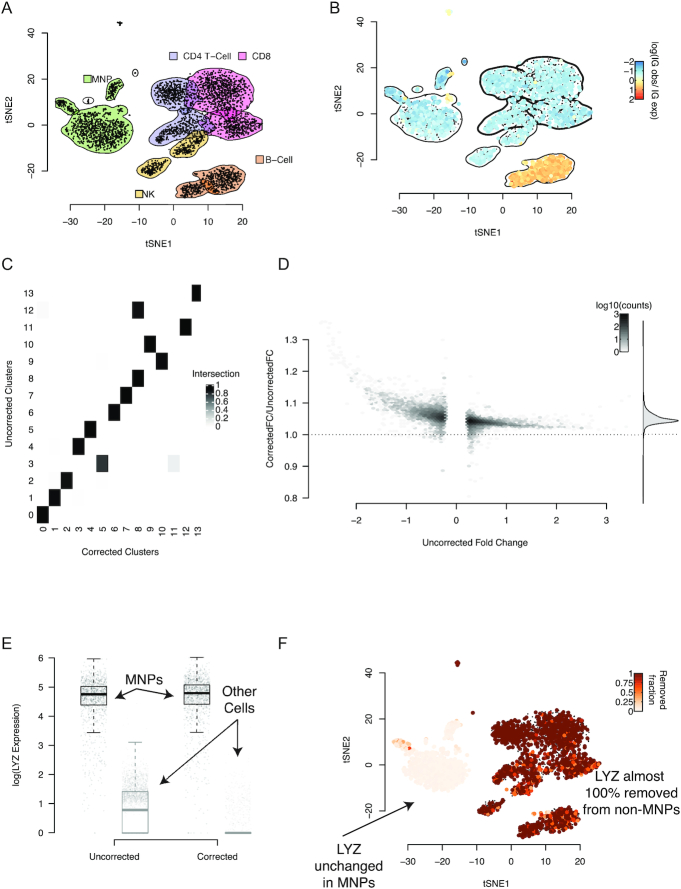
The PBMC dataset and how it changes when background correction is applied. A, A tSNE representation of the data, with cluster boundaries shown by density contours and shaded according to the cell type they represent. MNP: mononuclear phagocytes; NK: natural killer cells. B, The same tSNE representation, but cells are now coloured by their rate of expression of immunoglobulin (IG) genes compared to the rate at which IG is expressed in the background on a log10 scale. Positive values correspond to higher IG expression in a cell than in the background, with values significantly >0 only possible if the cell endogenously expresses IG. The density contours of the clusters with no cell that endogenously expresses IG (as determined by a Poisson test) are marked in boldface and used to estimate the global contamination ratio. C, The fraction of cells shared between clusters determined with the same parameters before and after application of SoupX. D, The improvement in marker specificity following application of SoupX. All genes that are markers of a cluster either before or after correction are identified and their expression log fold change (FC) relative to the clusters they do not mark is calculated before and after correction. The y-axis of this plot shows the fractional change in log FC after applying SoupX for all genes. Genes are grouped into bins for ease of representation, with the number of genes in each bin given by the colour scale. The marginal distribution across all genes is shown on the right and the dotted line corresponds to no change in marker specificity after correction. E, The improvement in marker sensitivity for the gene LYZ, which is a marker for mononuclear phagocytes (MNPs). The corrected and uncorrected expression levels are shown split by cells labelled as MNPs and all others. F, This same change in expression shown on the tSNE map, where the colour scale represents the fraction of LYZ expression that has been removed by SoupX.